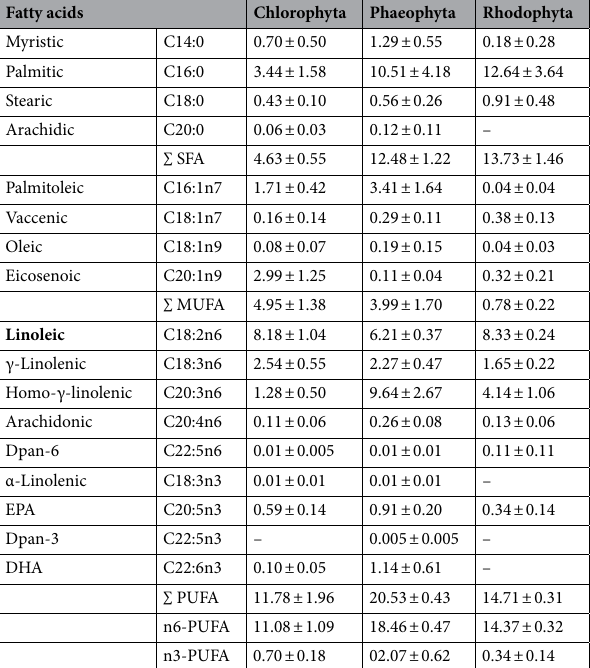
Table 5. Fatty composition values and the respective Green, brown and Red seaweed group (mean ± SE) %. – ; not available. Total saturated fatty acids (SFAs) = the sum of C8 to C20. Total mono unsaturated fatty acids (MUFAs) = the amount of C18:1. Total poly unsaturated fatty acids (PUFAs) = the sum of C18:2 and C18:3. Data are expressed as values: mean ± SE and analysed by one-way analysis of